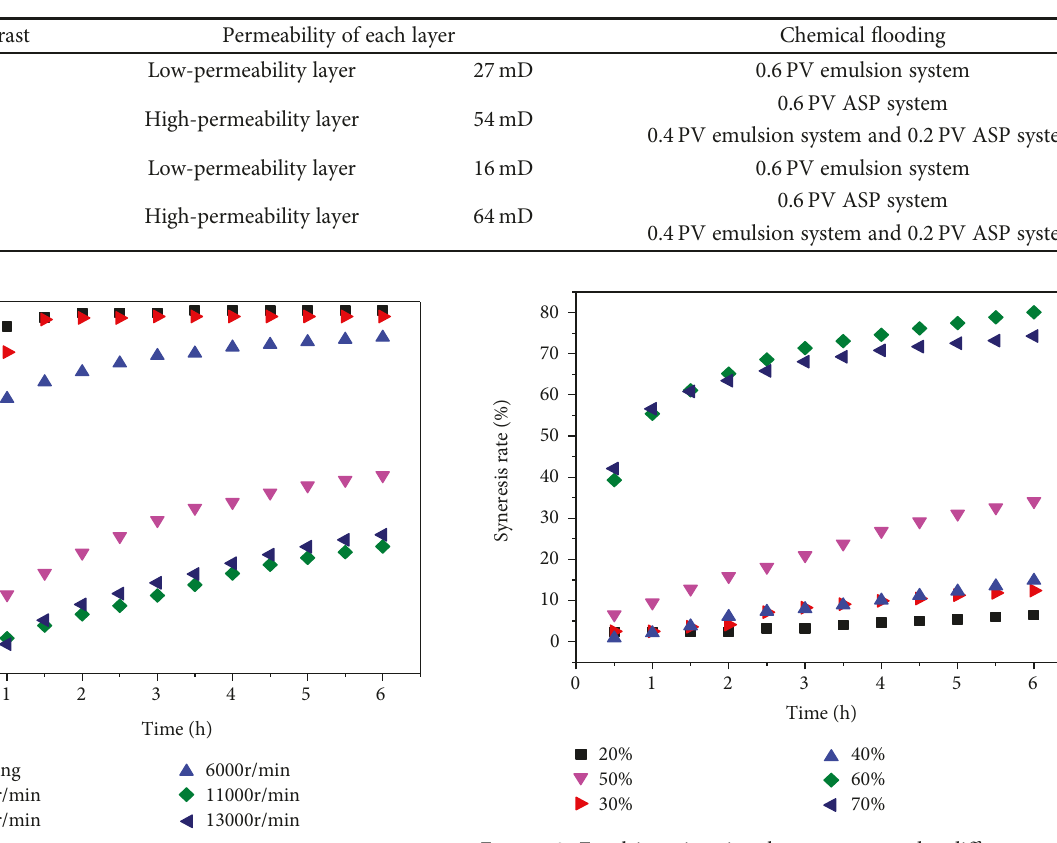
Figure 1: Diagram of the experimental setup. 1: plunger pump; 2: beaker; 3: simulated oil; 4: water; 5: chemical agent (ASP solution or kerosene emulsion); 6: pump sensor; 7: high-permeability layer core; 8: low-permeability layer core; 9: core holder; 10: high-precision cylinder; 11: oven; 12: manual pump. Table 2: Core parameters and chemical fl ooding slug composition.